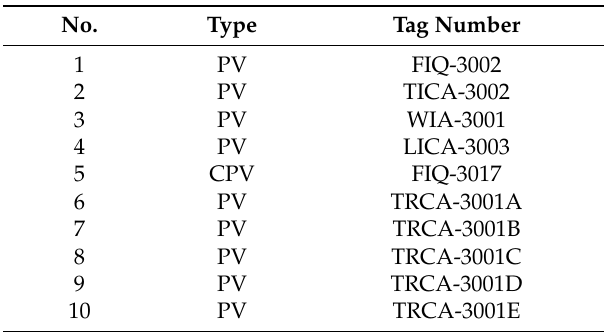
Table 1. Reactor R-301 related variables in R-22 producing process.